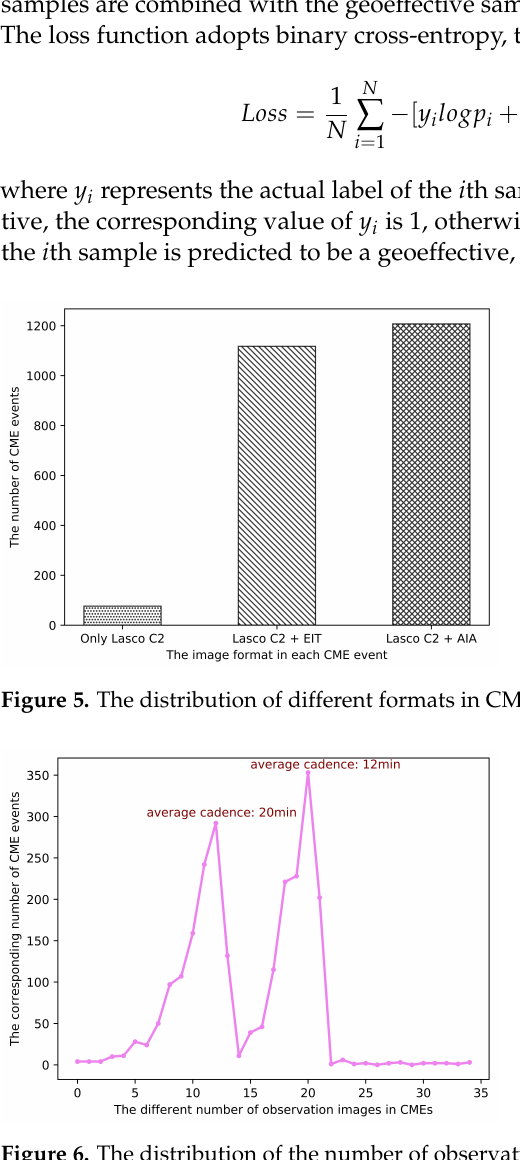
Figure 6. The distribution of the number of observation images in CME events. For the arrival time prediction of geoeffective CMEs, 246 geoeffective CME events are randomly divided into the training set and the testing set at approximately 8:1 ratio. Specifically, the training set contains 218 CME events and corresponding 3042 observation images while the testing set contains 28 CME events and corresponding 418 observation images. The training procedure is also performed in the PyTorch framework. In the training phase, we use AdamW as the default optimizer to update the parameters and avoid the network overfitting, the related parameters β 1 and β 2 are also set to 0.9 and 0.999, the weight decay coefficient is set to 0.01. We train with a total number of 100 epochs and the default batch size is 32. The learning rate is set to 0.01 initially, and is multiplied by 0.6 at epoch 40, 60 and 80. The comparing traditional convolutional neural networks all adopt L2 Loss and data expansion based on sample split in the training